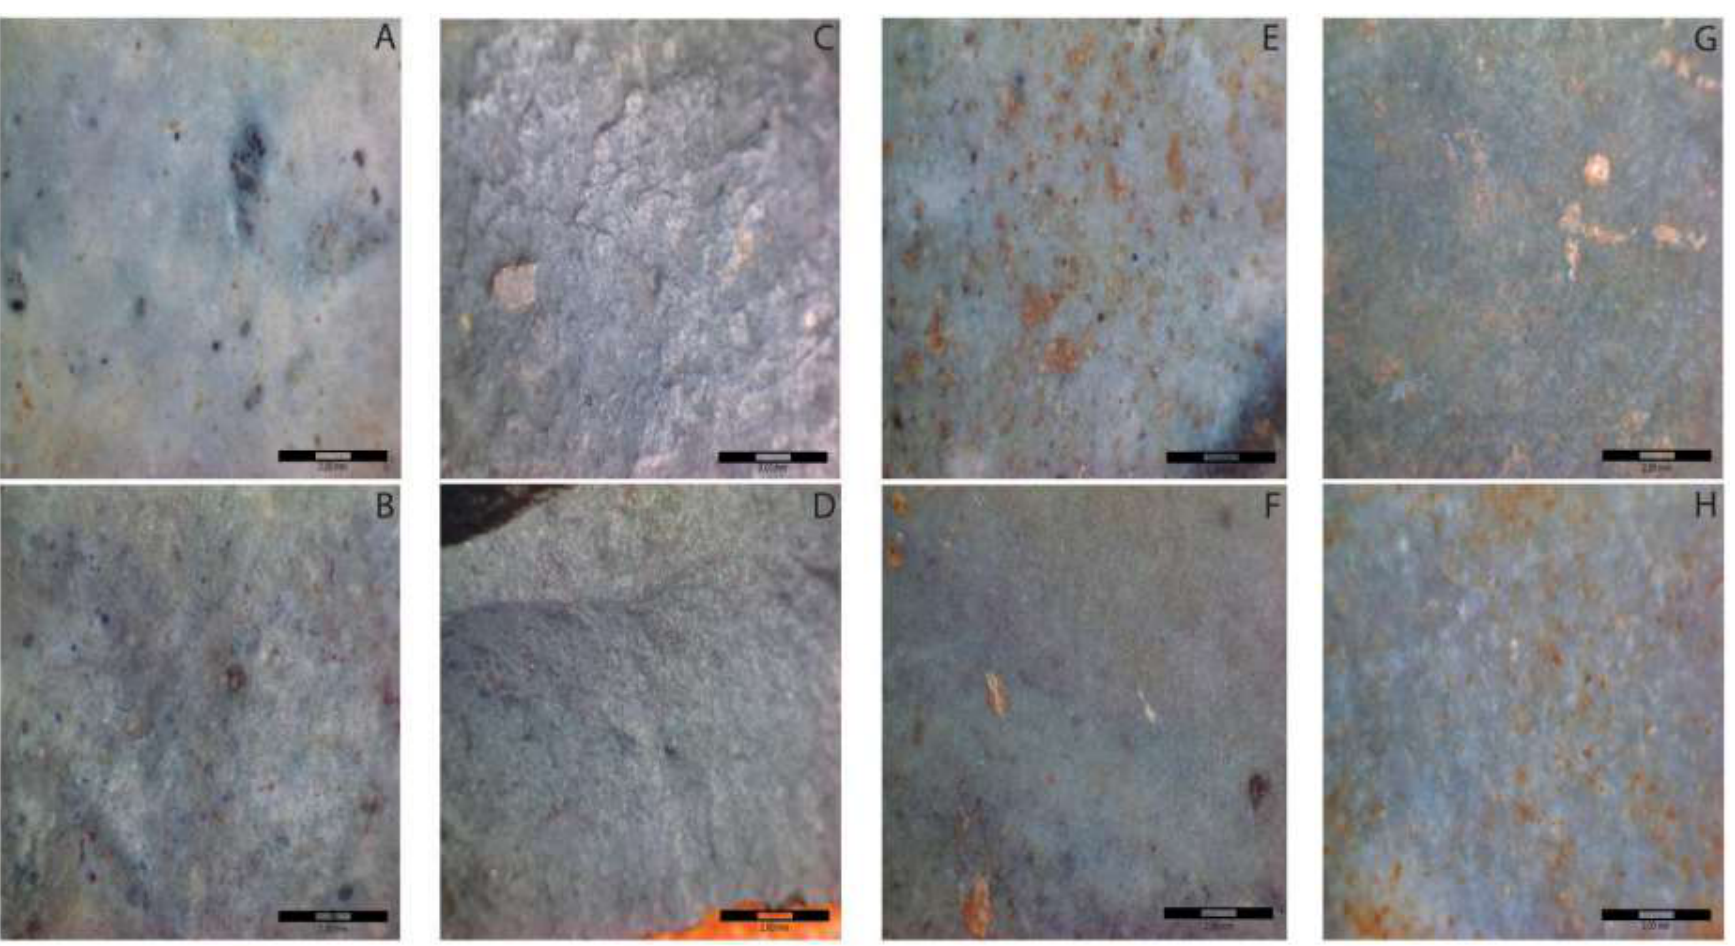
Figure 5. Mesoscopic aspects (x50) of the flint that characterizes the studied assemblage. Type 5: 5A and 5B; Type 6: 5C and 5D; Type 7: 5E and 5F; Type 8: 5G; Type 9: 5H. The scale bars are 2 mm in total. Each segment is 0.67